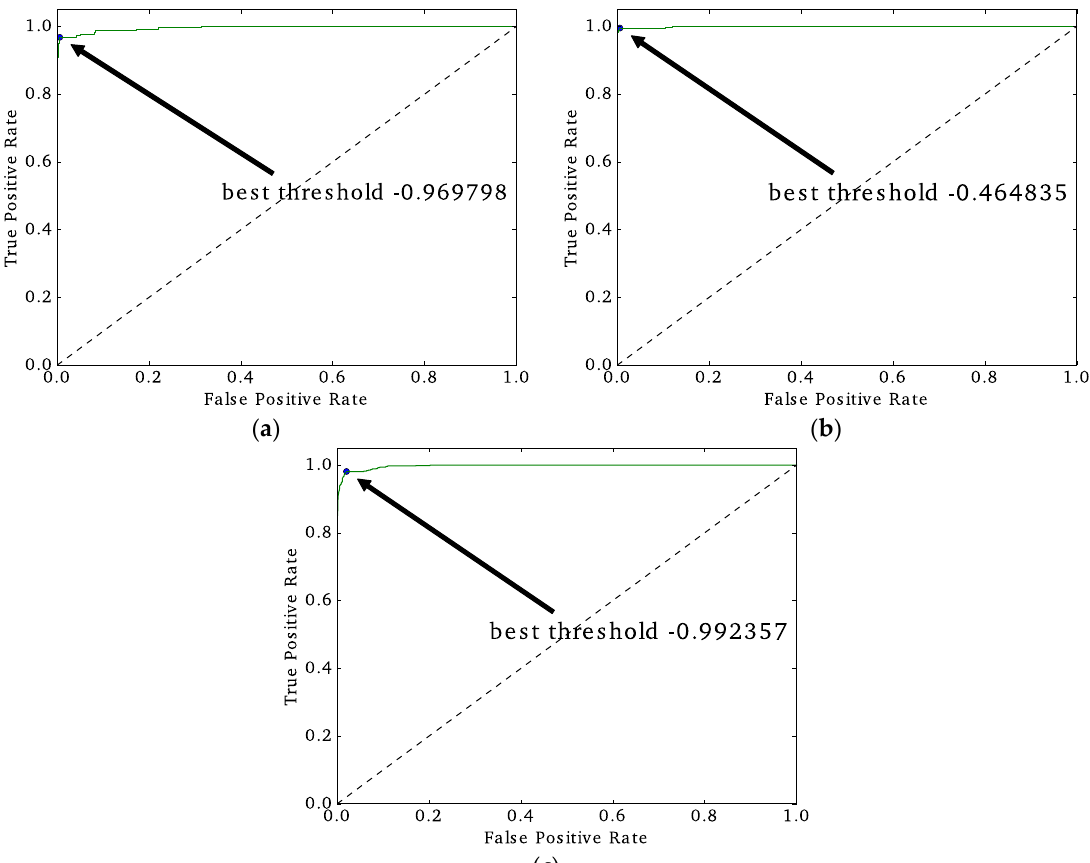
Figure 9. ROC curves used to select the best decision threshold: ( a ) Buenos Aires; ( b ) Medellin; ( c ) Recife. For visualization purposes, the x -axis is reported in logarithmic scale. The final regularization term is reported in Table 7. Table 6. Tuning the best classification models ( F2 -scores).